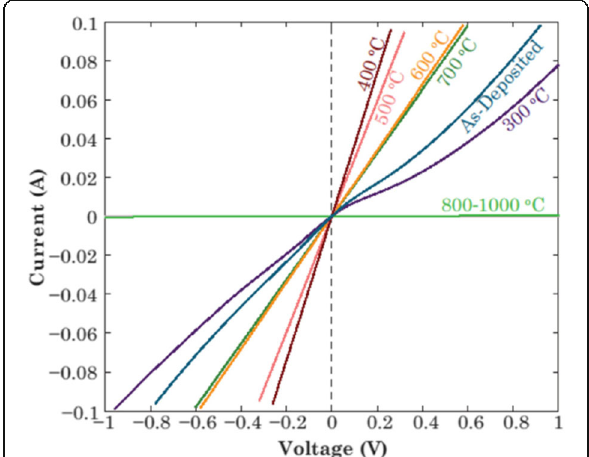
Fig. 9 I – V plots for Ti/Au contacts on Sn-doped ( (cid:1) 201) Ga 2 O 3 wafer as a function of annealing temperature in Ar (annealing time 1 min). Reproduced from Ref.